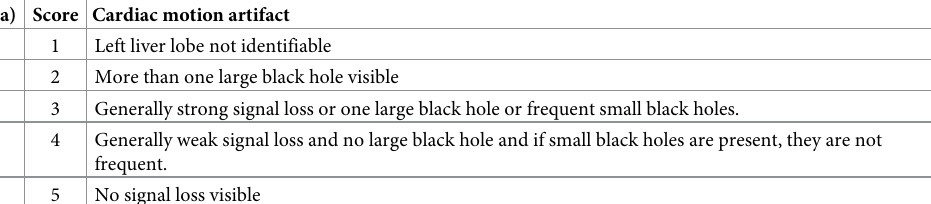
Table 1. Definition of the Likert score for the visual assessment of the cardiac motion artifact. (a) Score Cardiac motion